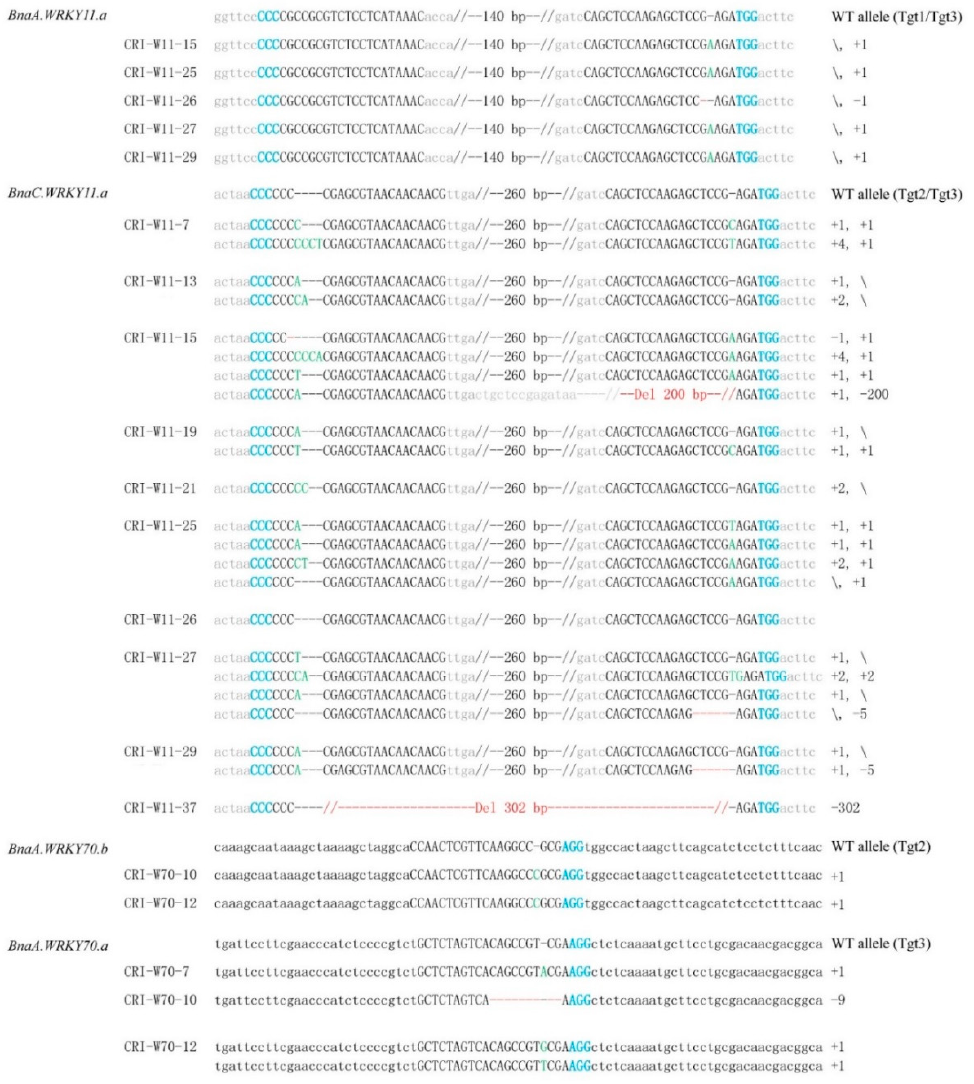
Figure 3. Multiplex mutagenesis of B . napus genome in T 0 generation. The protospace adjacent motif (PAM) is shown in bold blue letters; red dashes mark the deletions; the inserted nucleotide is marked by a green letter. The numbers on the right show the type of mutation and how many nucleotides are involved, with “ − ” and “+” indicating deletion or insertion of the given number of nucleotides, respectively. Tgt1-Tgt3 means the target sequence used to generate sgRNA expression cassette.